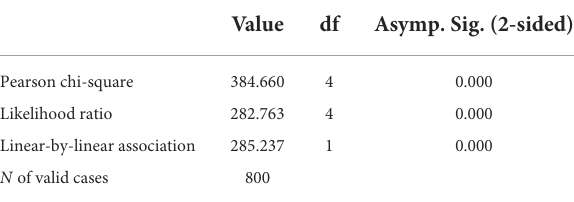
TABLE 5 Chi-square test between the dimension of tangibles and satisfaction for the quality of services in public hospitals.